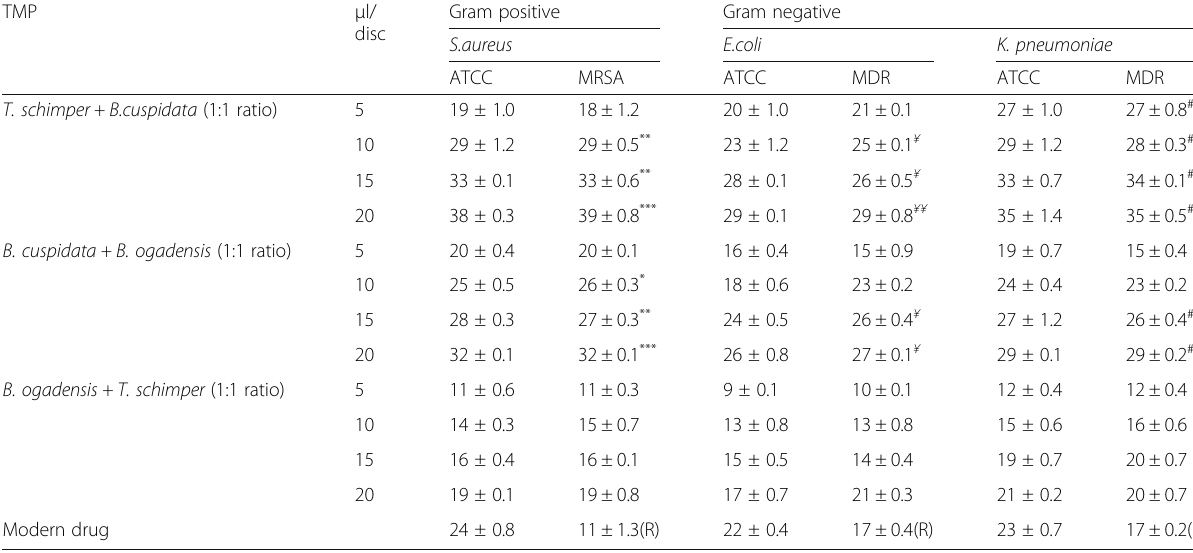
The values represent mean±standard deviation, N NO inhibition zone, R Resistant ( ≤ 16mm IZ), S=Susceptible ( ≥ 21mm IZ). Where, * P <0.05, ** P <0.01, *** P < 0.001when compared to cefoxitin treated MRSA. While, # P <0.05, ## P <0.01when compared to modern drug treated K. pneumoniae and ¥ P <0.05, ¥¥ P <0.01 when compared to modern drug treated E.